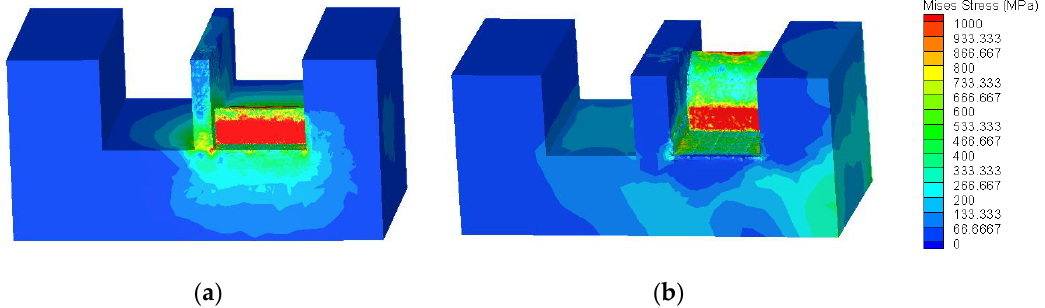
Figure 4. Mises stress distribution of microtexture at different widths: ( a ) w idth = 10 μm , ( b ) width = 20 μm.